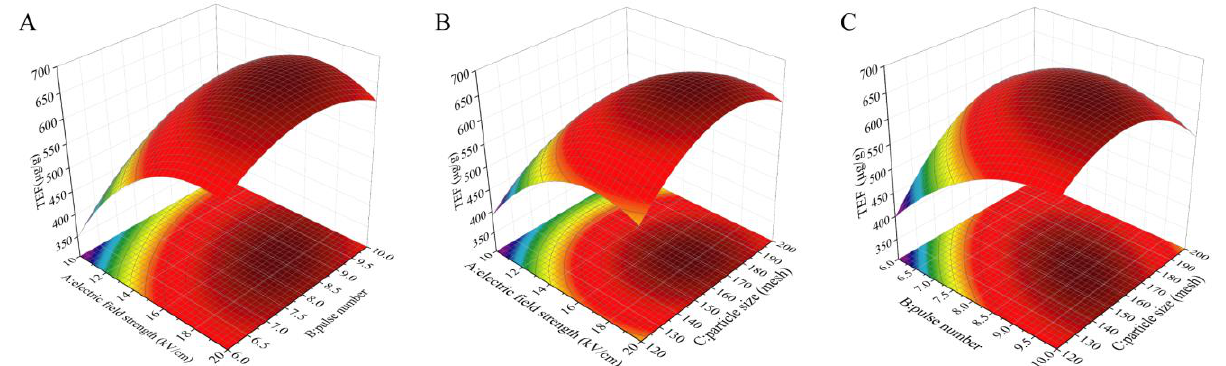
Figure 3. Interaction diagrams of various factors: ( A ) Electric field strength and pulse number; ( B ) Electric field strength and particle size; ( C ) Pulse number and particle size. Table 3. Validation optimized conditions of RSM and GABP model.